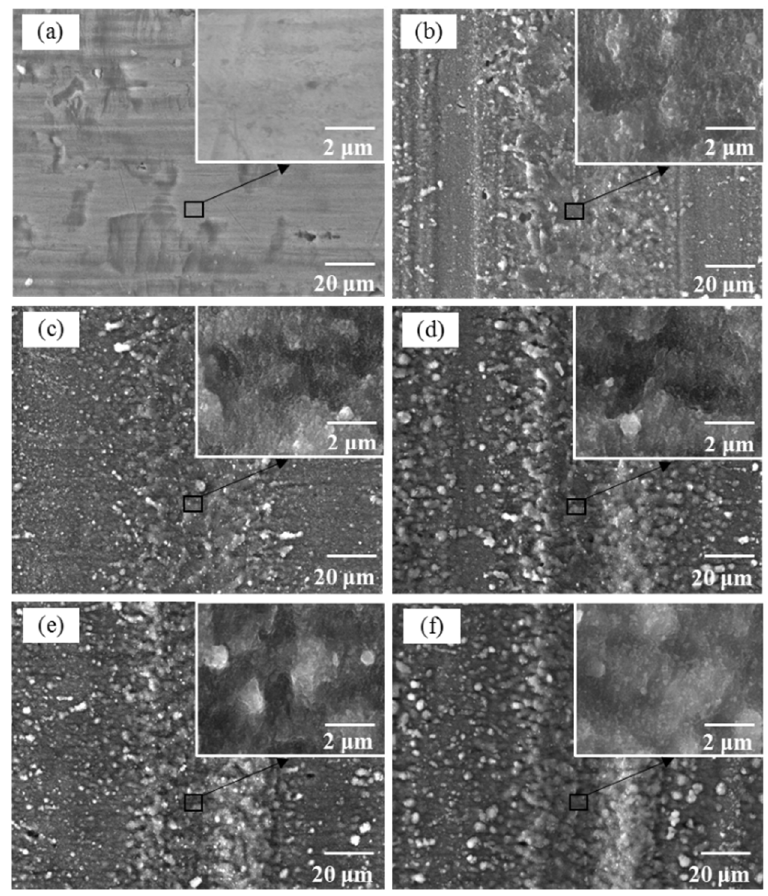
Figure 6. SEM images of the samples: ( a ) P-0, ( b ) P-1, ( c ) P-2, ( d ) P-3, ( e ) P-4, ( f ) P-5.